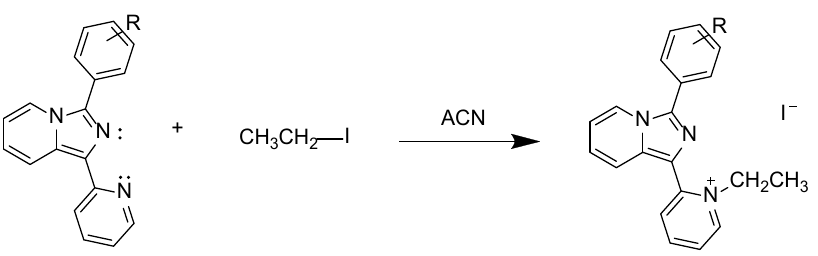
Scheme 1. General reaction scheme of one-pot microwave-assisted cycloaddition used for 1 – 3 . Ben- zaldehyde, terephthaaldehyde and isophthalaldehyde were employed for 1 – 3 , respectively.